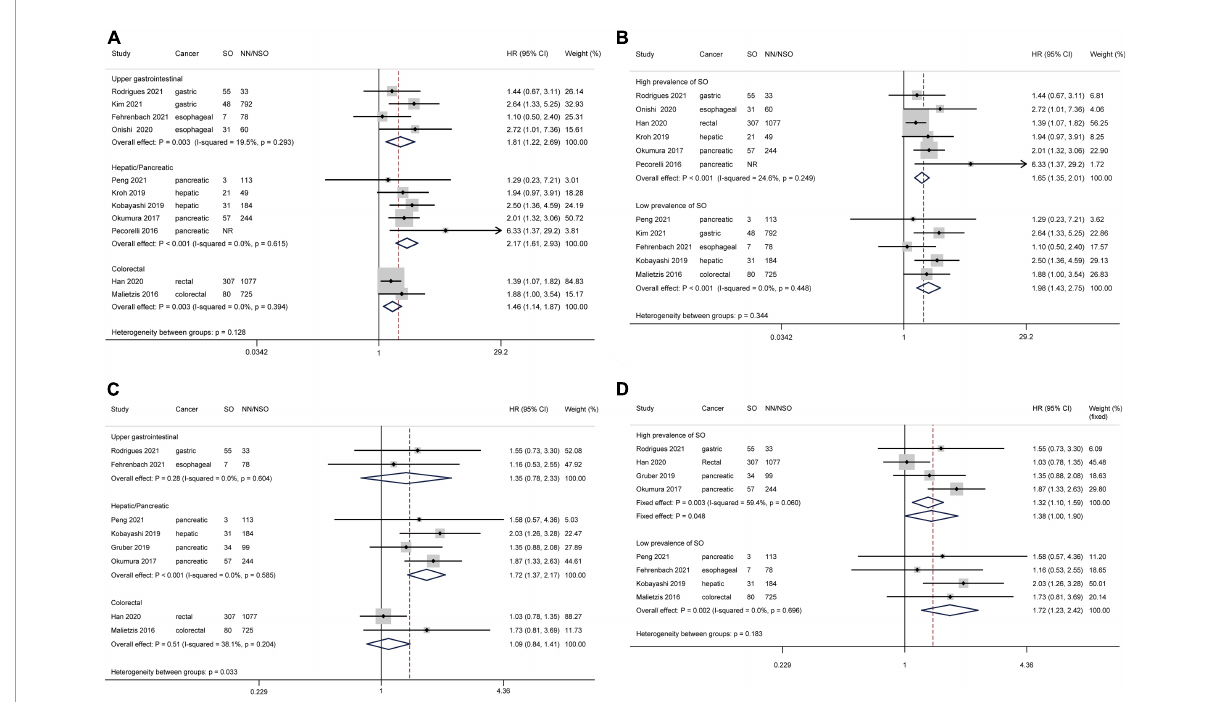
FIGURE4 Forest plots of subgroup analyses for sarcopenic obesity and survival outcomes stratified by cancer type and sarcopenic obesity prevalence. Overall survival: (A,B) Disease-free survival: (C,D) CI, confidence interval; HR, hazard ratio; NN, non-sarcopenia non-obesity; NR, not reported; NSO, patients without sarcopenic obesity; SO, sarcopenic